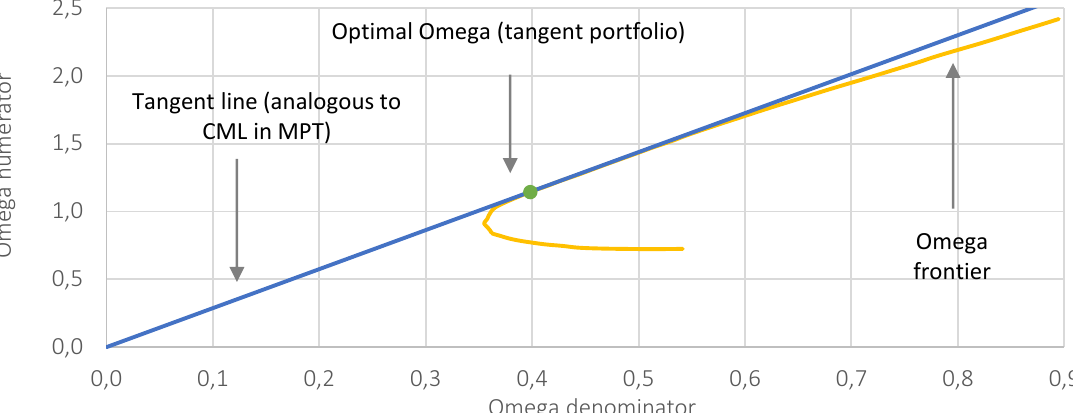
Figure 1. Ω frontier, analogous capital market line, and location of the optimal Ω portfolio